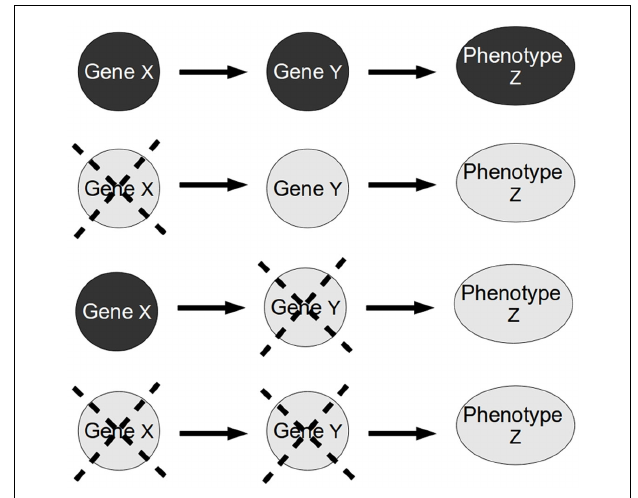
FIGURE 2 | Standard epistasis analysis. In epistasis analysis one compares the effect of each single mutant ( X and Y single gene mutants) against the double mutant ( XY double mutant) of the genes under study on the phenotype of a trait (in this paper, the trait represents a gene).The masking of the effect of one gene mutation in the double mutant is called epistasis.The gene whose phenotype persists is called epistatic